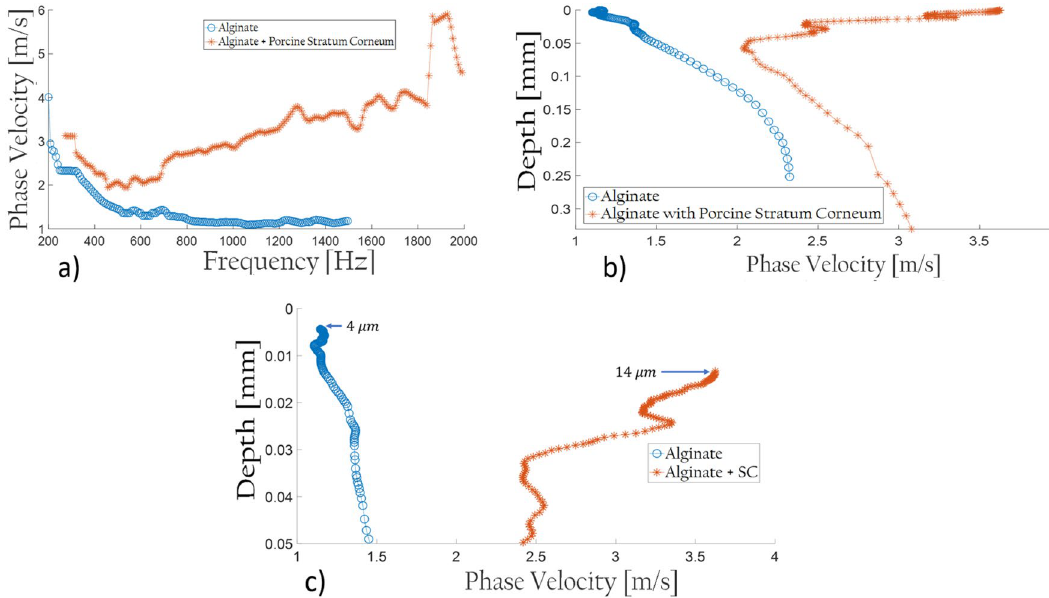
Figure 1. ( a ) Dispersion curve outcomes of Alginate and Alginate with Porcine Stratum Corneum atop. ( b ) Velocity profiles resulted from the dispersion curves with the inversion model applied. ( c ) Close-up on the velocity profiles resulted from the dispersion curves with the inversion model